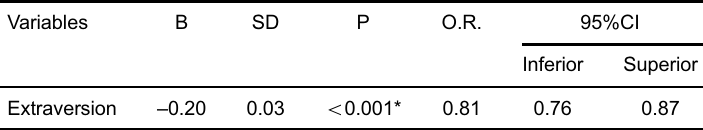
Table 3. Final model of logistic regression for alcoholism prediction.